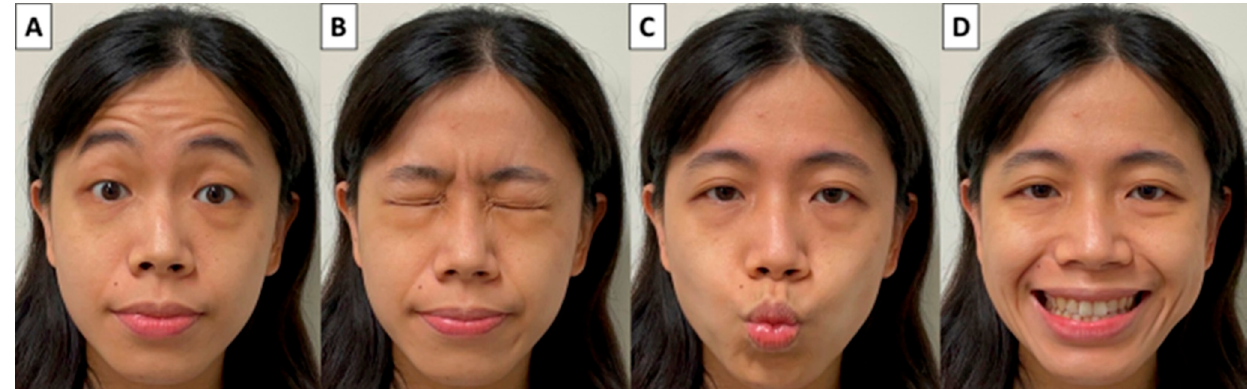
Figure 4. Four main facial movements for assessing facial expressions after parotid surgery. ( A ) Wrinkling foreheads, ( B ) tightly closing eyes, ( C ) whistling and ( D ) a wide smile.